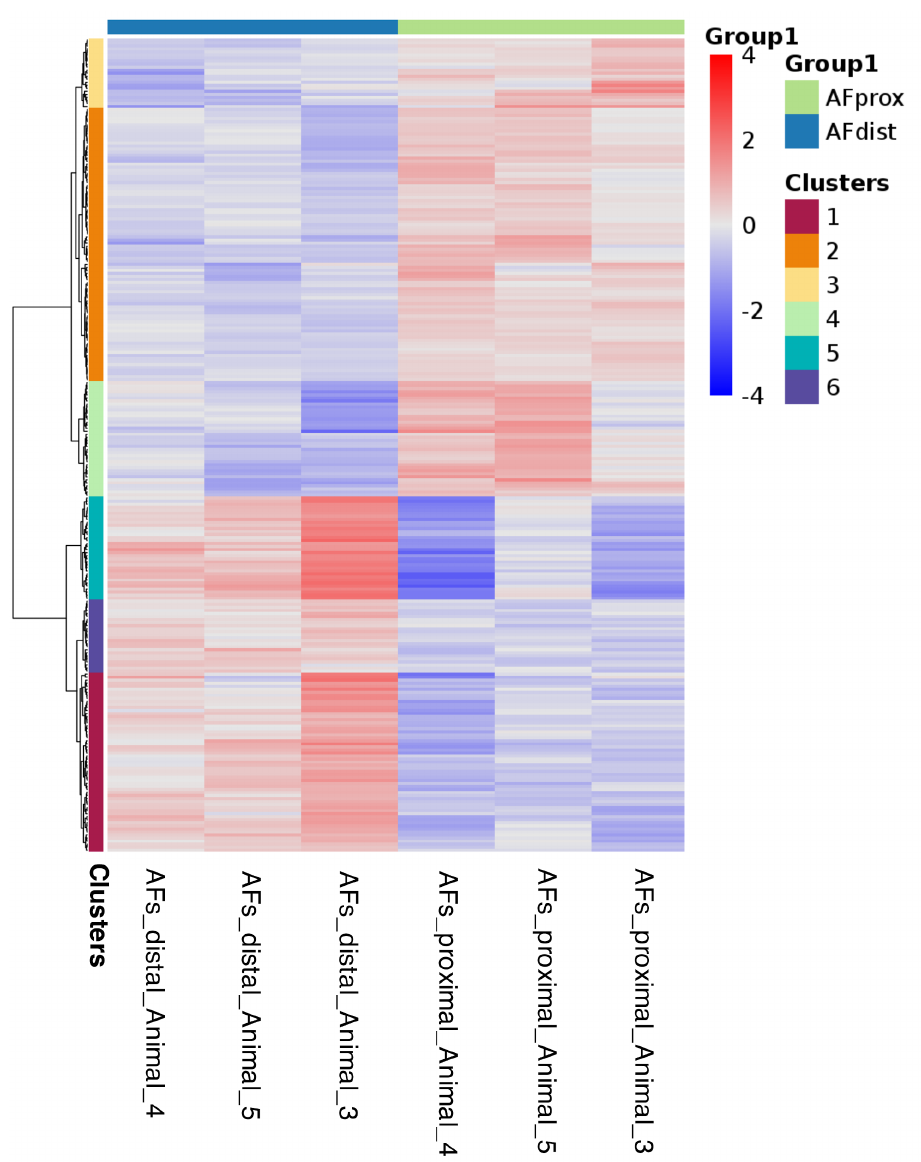
Figure 5. Heat map bulk AFs. Heat map for the differential genes expression for proximal and distal AFs (bulk